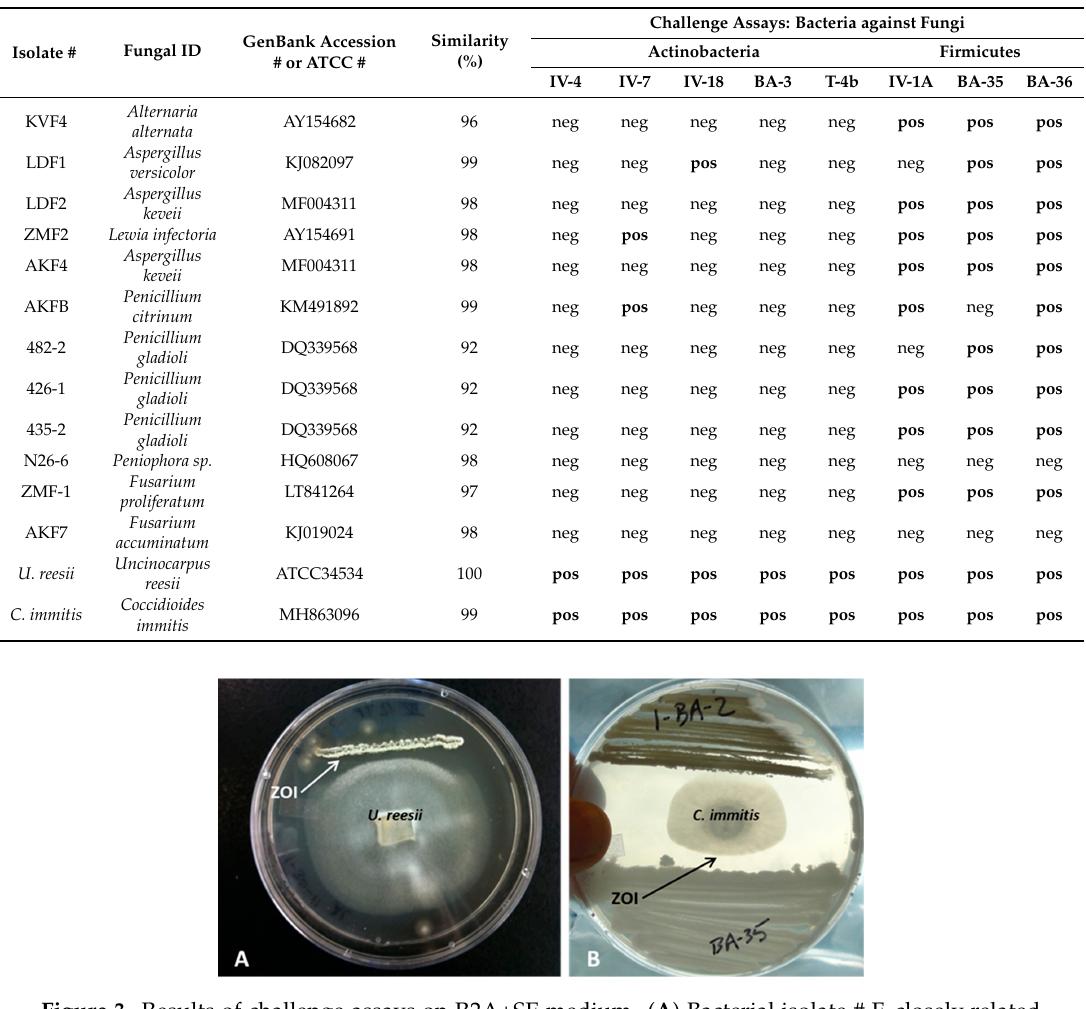
Table 2. Challenge assays of bacterial isolates against environmental fungal isolates revealed differences in antifungal spectra.